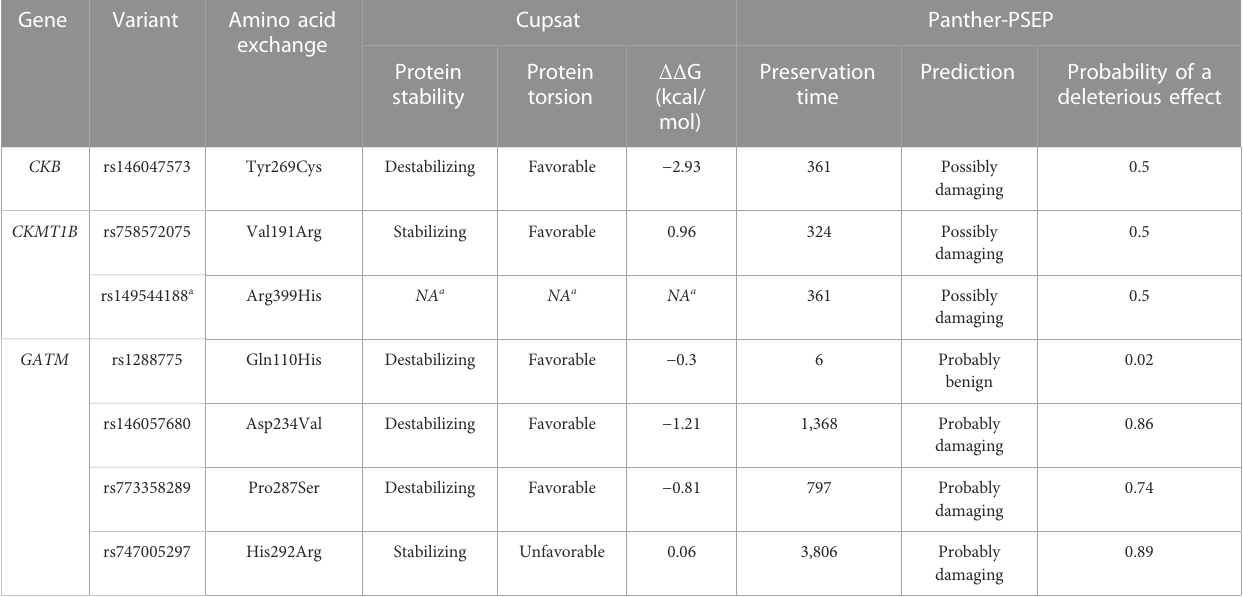
TABLE 5 In silico predictions of putative effects of non-synonymous variants on protein structure. The effect predictions were obtained with the CUPSAT tool (Parthiban et al., 2006) utilizing the protein structures of CKB (PBD ID: 3DRE; Bong et al., 2008), CKMT1B (PBD ID:1QK1;Eder etal., 2000) and GATM (PBD ID:2JDW; Humm et al., 1997) and the PANTHER-PSEP tool (Tang and Thomas, 2016). As no full-length PBD protein structure was available for CKMT1B , we could not determine the impact of rs149544188 ( a ). As only non-synonymous variants could be predicted, the non-sense variant rs1230355611 (p. Arg184Stop) in CKMT1B was not